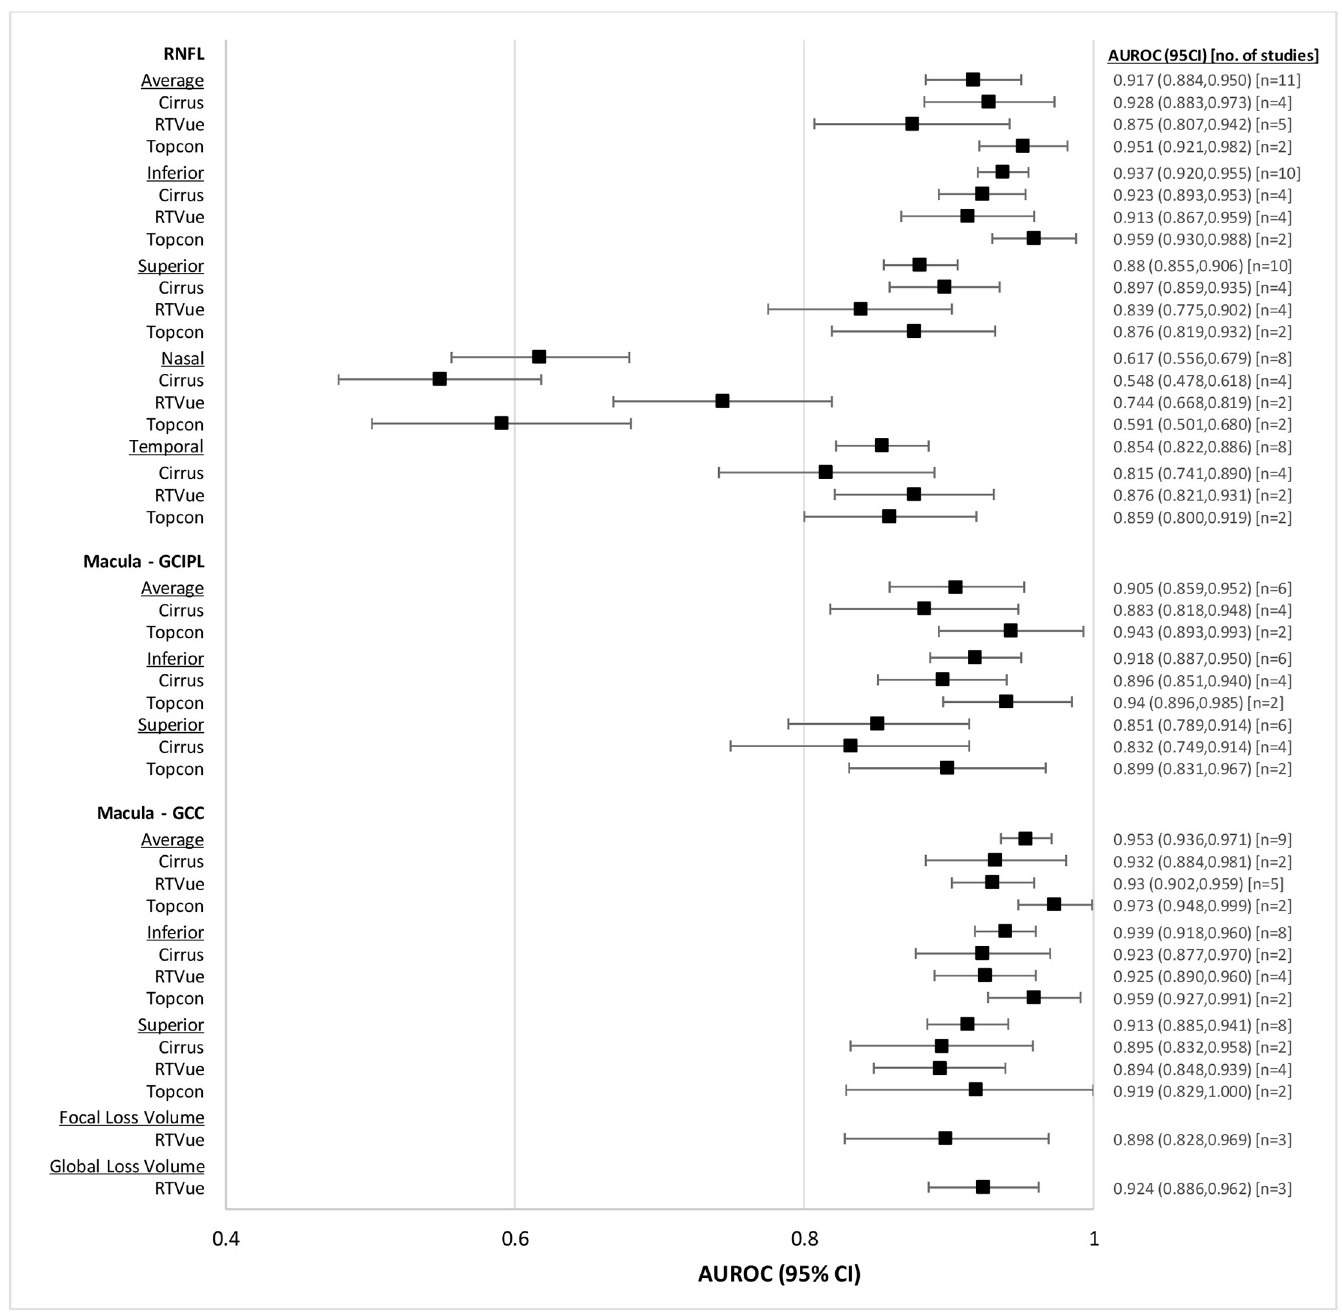
Fig 8. Forest plot of diagnostic accuracies of RNFL and macular OCT parameters, myopic patients.